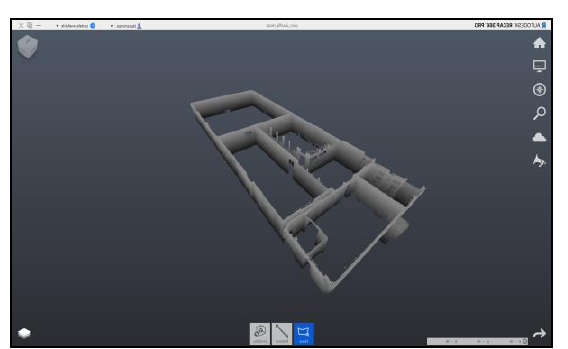
Figure 14. Dimensioning for TLS data in Revit software